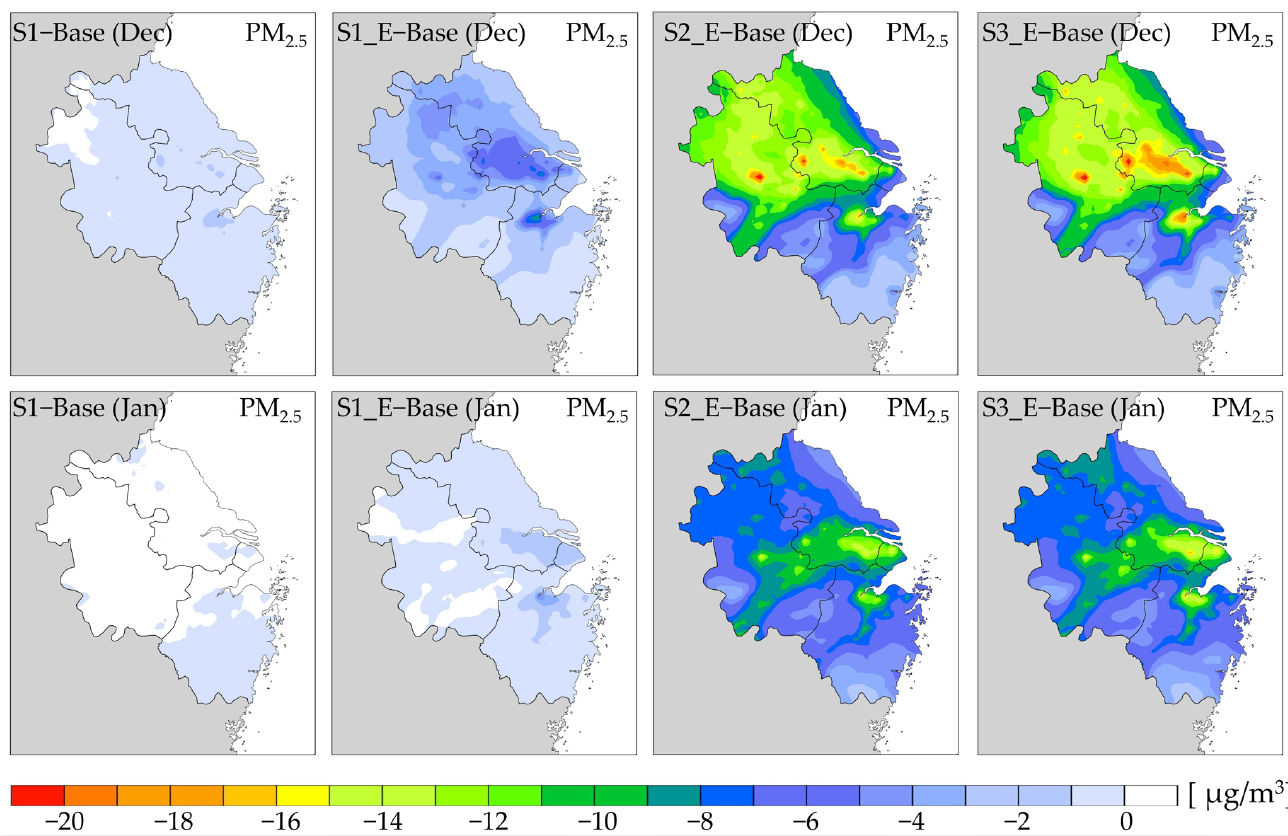
Figure 3. Spatial distributions of PM 2.5 concentration decrease values under the 4 control scenarios relative to the base case over the YRD region in January (Jan) and December (Dec), 2025. Table 3. Predicted average decrease values of winter PM 2.5 concentrations under the 4 control sce- Overall, the PM 2.5 decreases in these 41 cities in December were larger than those in narios relative to the baseline in 41 main cities of YRD in 2025. January for the same control scenarios. Compared to the S1 scenario, the S1_E scenario had wider decrease areas and higher decrease values of PM 2.5 concentrations (Figure 3), Base S1 － Base consistent with the intensities of emission controls (Tables 1 and 2). In January, under the scenarios of S2_E and S3_E, the PM 2.5 decreases in the central Anhui, southern Jiangsu, northern Zhejiang and Shanghai were relatively large. Under the S1 scenario designed on the basis of the emission reduction scheme reported in the 13th FYP, the average PM 2.5 decreases in these 41 cities in the YRD in winter were less than 2 µ g/m 3 . Under the S1_E scenario, the monthly average concentrations of city mean PM 2.5 were predicted to decrease by − 7.6 µ g/m 3 in Anqing city of Anhui province, followed by − 5.8 µ g/m 3 in Ningbo city of Zhejiang province, − 5.4 µ g/m 3 in Zhenjiang city of Jiangsu province, and − 1.4 µ g/m 3 in Shanghai in December (see Table S4). Compared with those in December, the decrease values in January were expected to be less due to its lower baseline concentrations. For example, it was predicted that by January 2025, under the S1_E scenario, the maximum values of average decreases in city mean PM 2.5 in each province in both Suzhou city (in Anhui province) and Yangzhou city (in Jiangsu province) would reach − 3.5 µ g/m 3 , followed by − 1.1 µ g/m 3 in Jiaxing city of Zhejiang province and − 0.7 µ g/m 3 in Shanghai. As shown in Figure S4, under the S1 and S1_E scenarios, the decrease percentages of PM 2.5 in the YRD were predicted to be less than 10%. Although the overall emission reductions in SO 2 , NOx and VOCs in the YRD were strengthened under the S1_E scenario, the average concentrations of city mean PM 2.5 were predicted to decrease only by 10% by 2025, indicating that the emission reduction intensities under the S1_E scenario were not enough to meet the requirements of the 14th